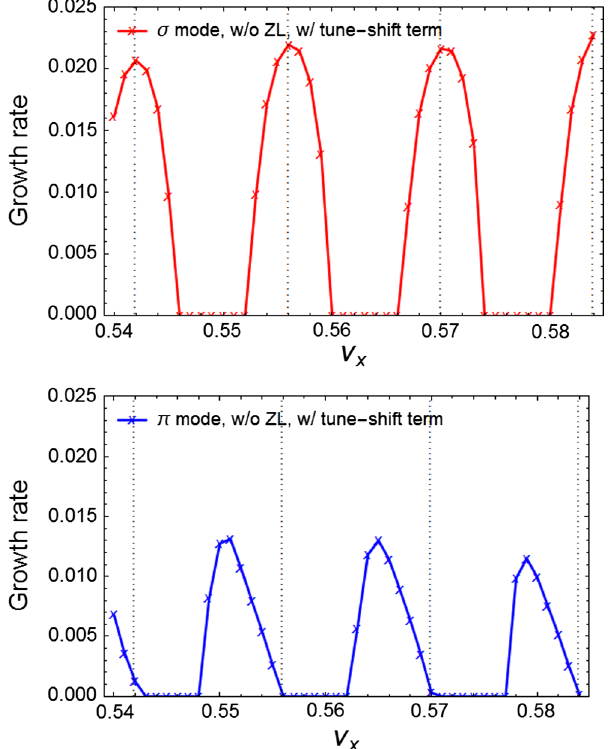
FIG. 17. Growth rate vs horizontal tune, where we also consider the second tune-shift term of Eq. (22) but without the longitudinal impedance (ZL). The red and blue points represent the σ and π modes,